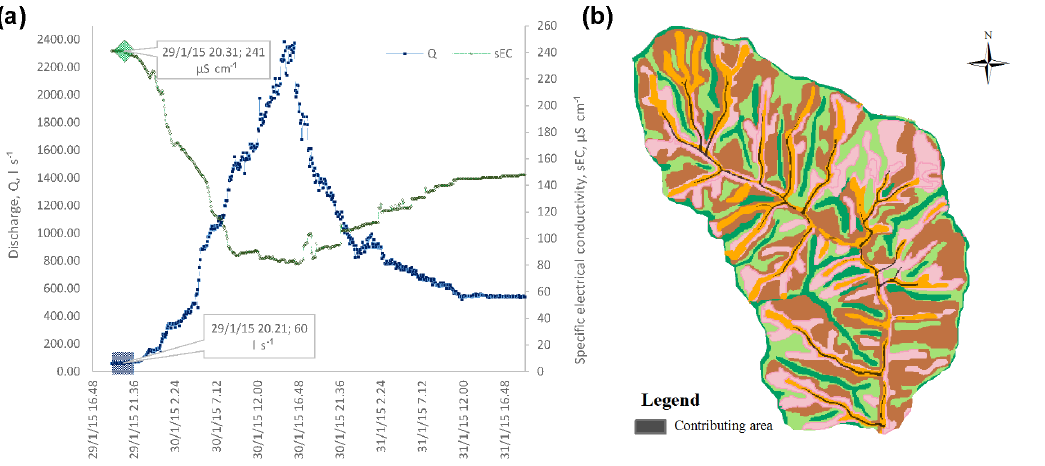
Figure 9. (a) Pre-event hydro-chemograph conditions, just before the storm event, with Q = 60Ls − 1 , filled blue square, and EC = 240µS − 1 , filled green diamond, (b) scenarios corresponding to groundwater and decreasing groundwater ridging contribution to streamflow running exclusively along the riparian corridor and main